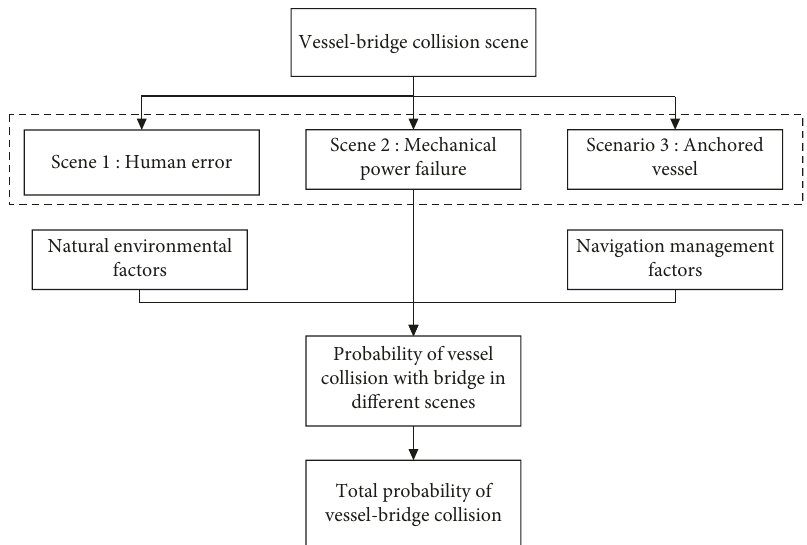
Figure 3: Flow chart of vessel-bridge collision probability